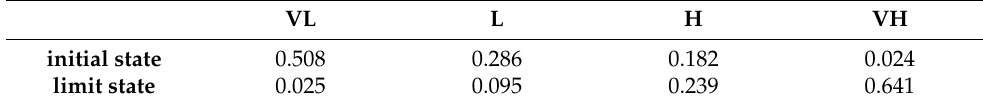
Table 5. Long-term projections of distribution of green development level of